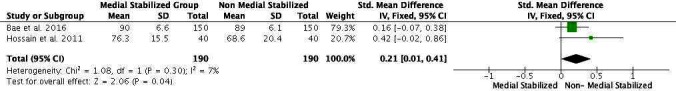
 Forest plot of final KSS value of medial stabilized group and non-medial stabilized group (SD: Standard Deviation; CI: Confidence Interval).